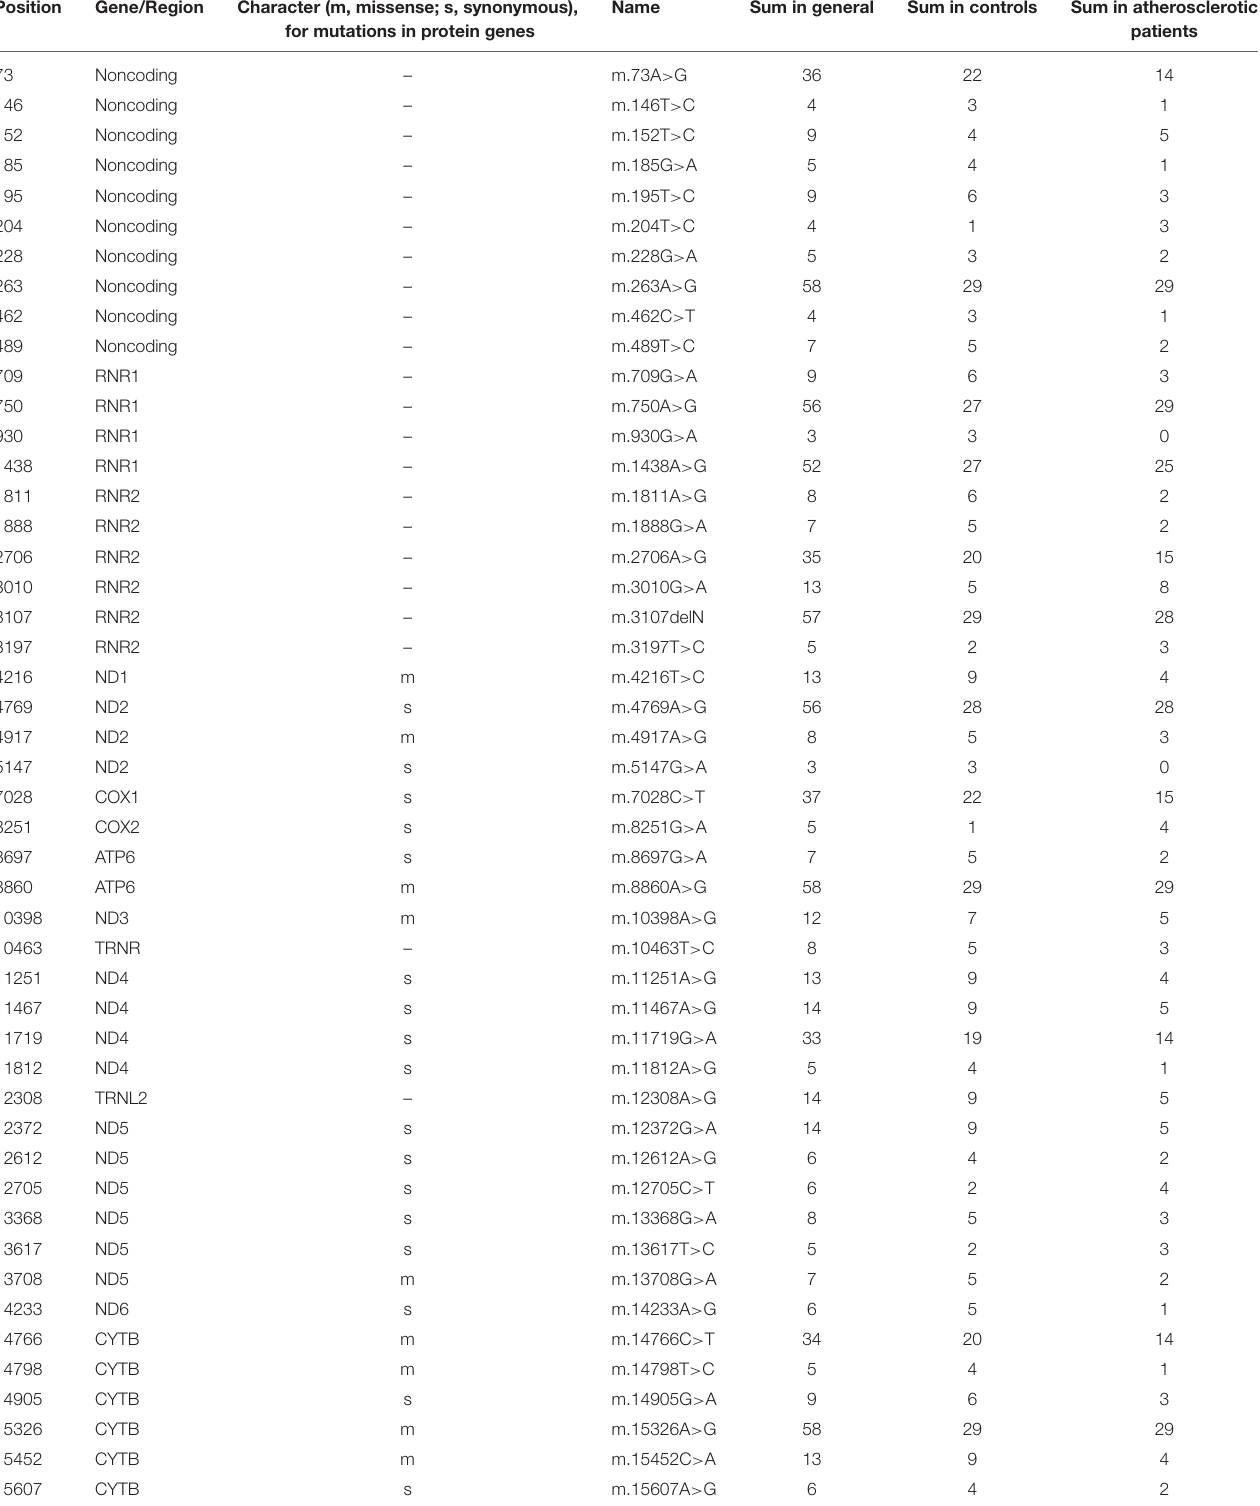
TABLE 1 | Common homoplasmic mutations, identified in the study. Position Gene/Region Character (m, missense; s, synonymous), Name Sum in general Sum in controls Sum in atherosclerotic for mutations in protein genes